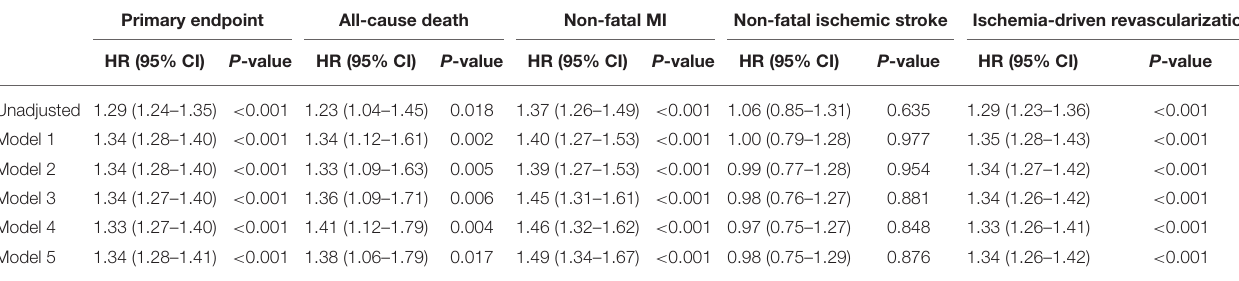
TABLE 4 | Predictive value of VAI as a continuous variate for the primary endpoint and each